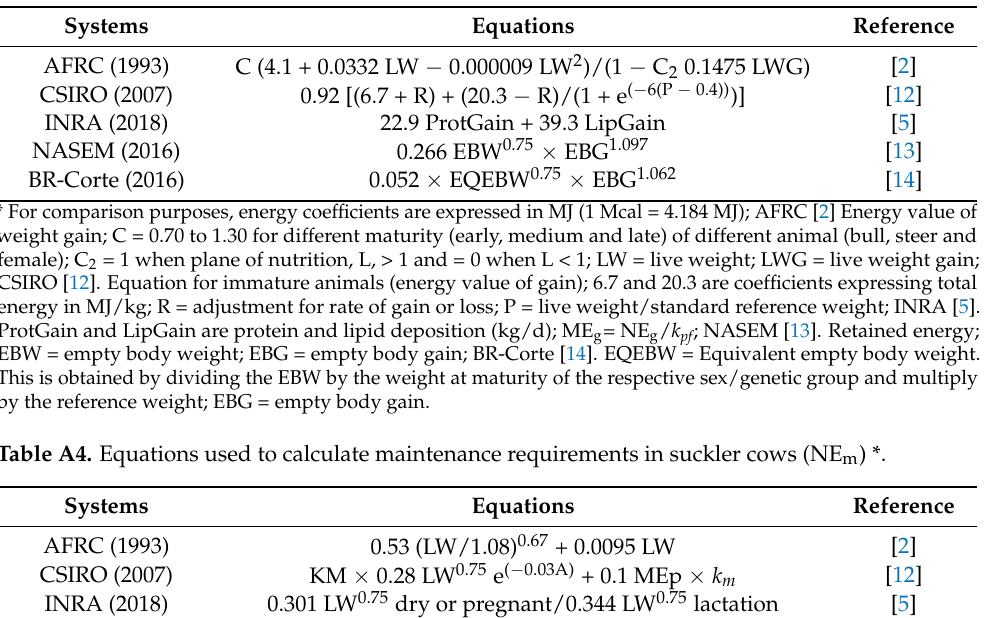
Table A3. Equations used to calculate energy requirements for LW gain (NE g ) *.